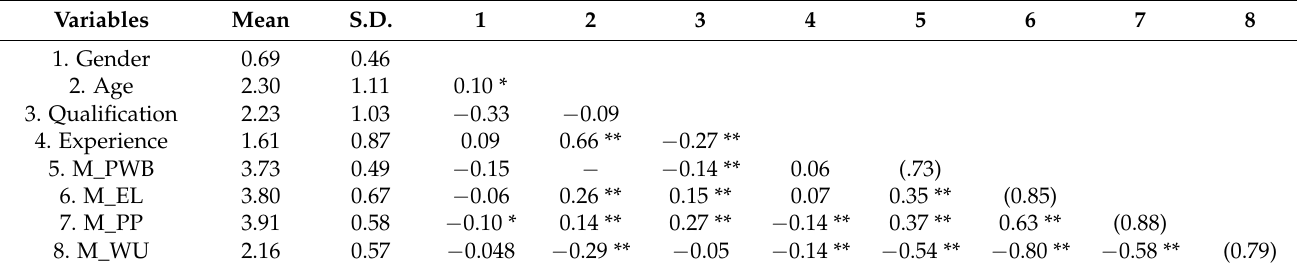
Table 2. Descriptive statistics, reliability, and correlation